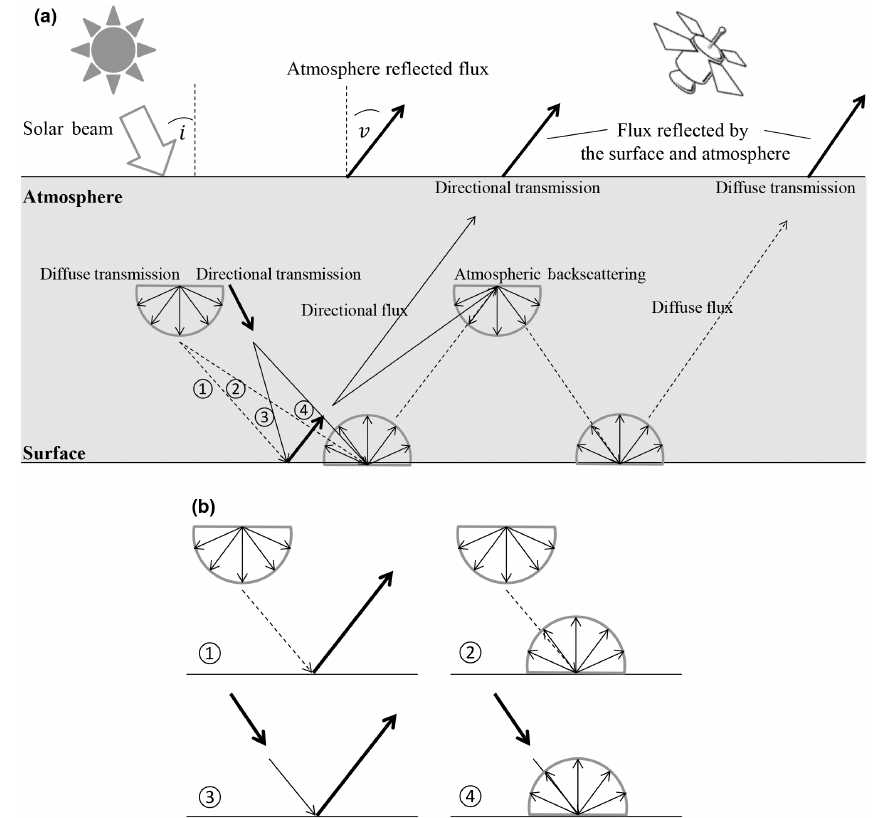
Figure 2. The TOA flux observed by the satellite considering the surface BRDF effects. The surface BRDF is simply described as four elements: hemispherical-directional (1), bihemispherical (2), bidirectional (3) and directional-hemispherical reflectance/reflection (4), also shown in panel (b) . More details are explained in the text.